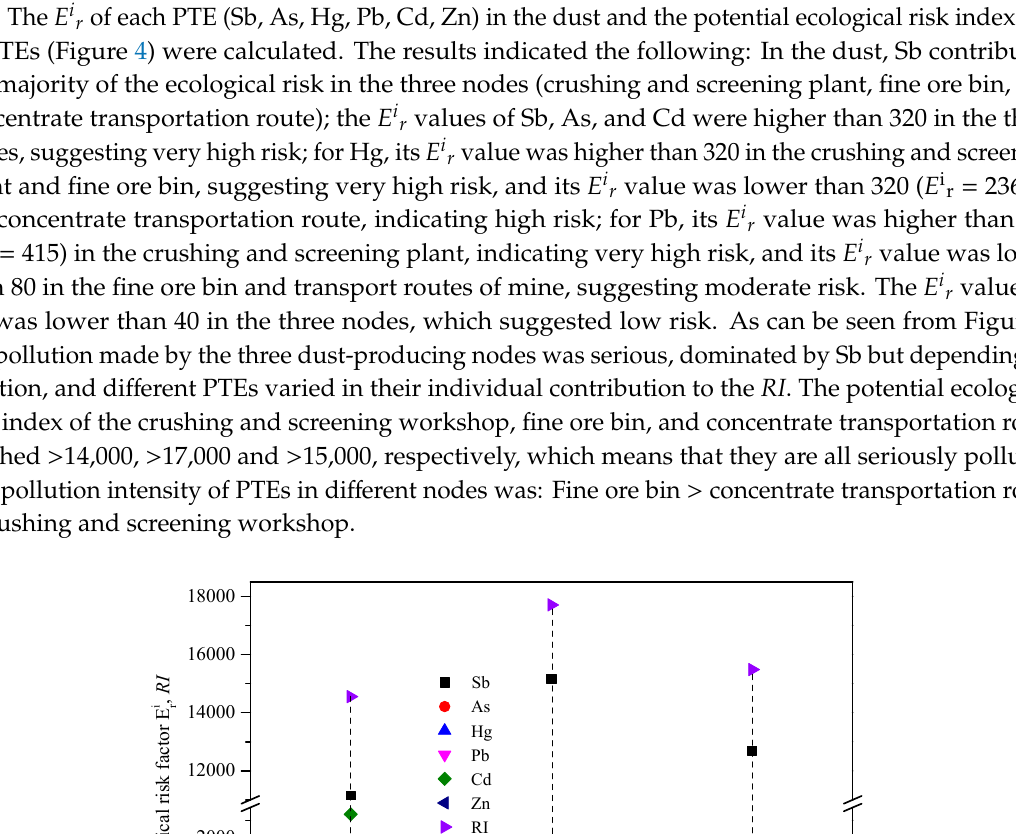
Figure 4. Evaluating results by E ir and RI.